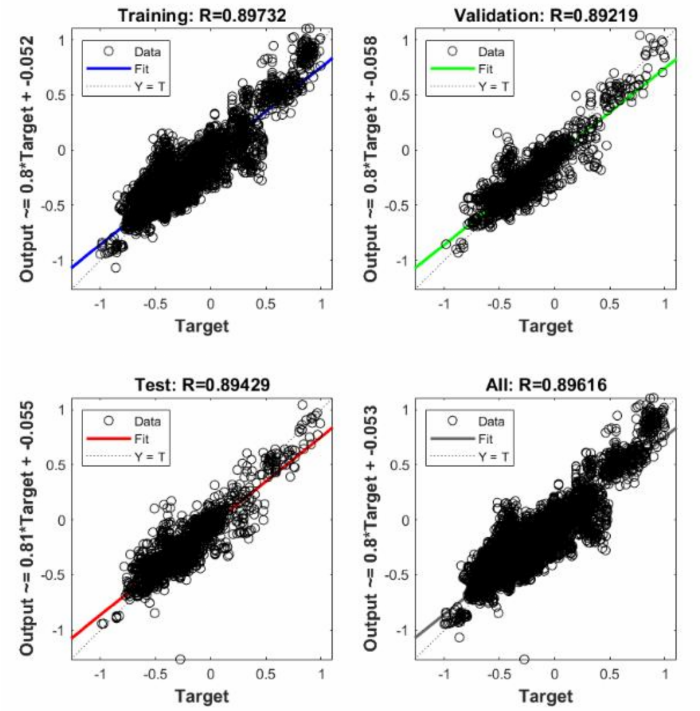
Figure 6. Training validation test sample regression